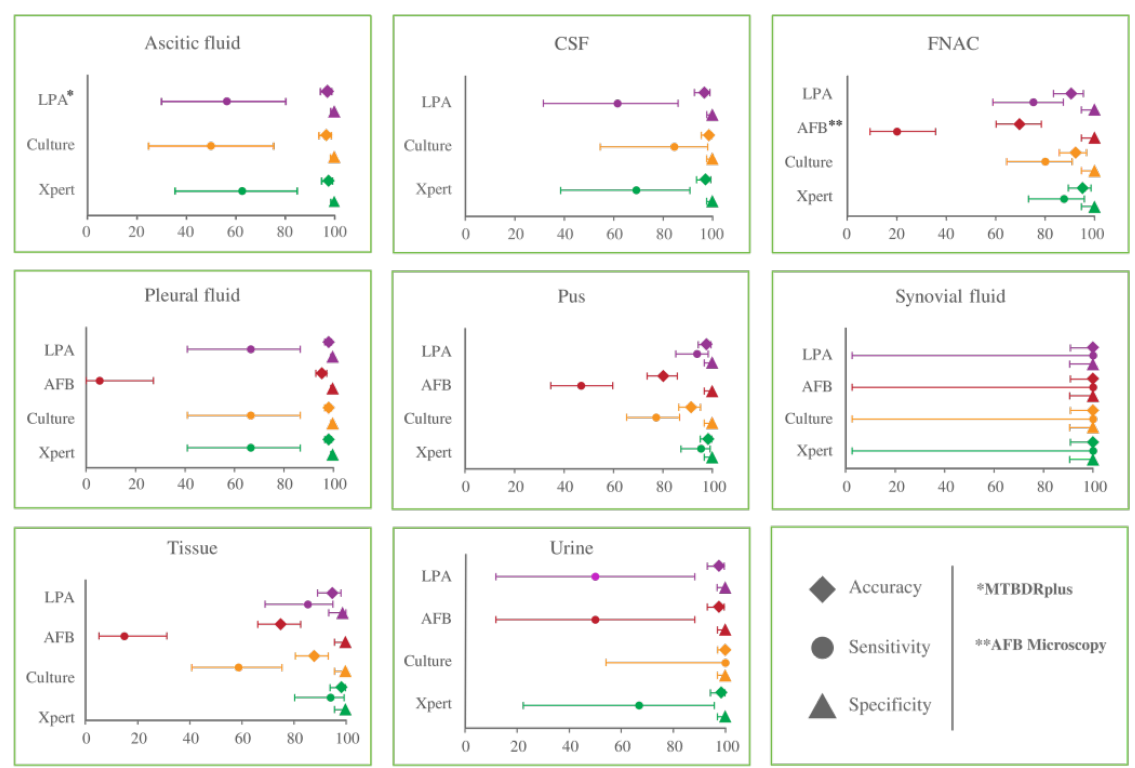
Figure 3. Diagnostic performance of four laboratory methods compared to CRS for EPTB detection in different specimen types. The bar represents a 95% confidence interval of three different diagnostic parameters: sensitivity, specificity, and accuracy .